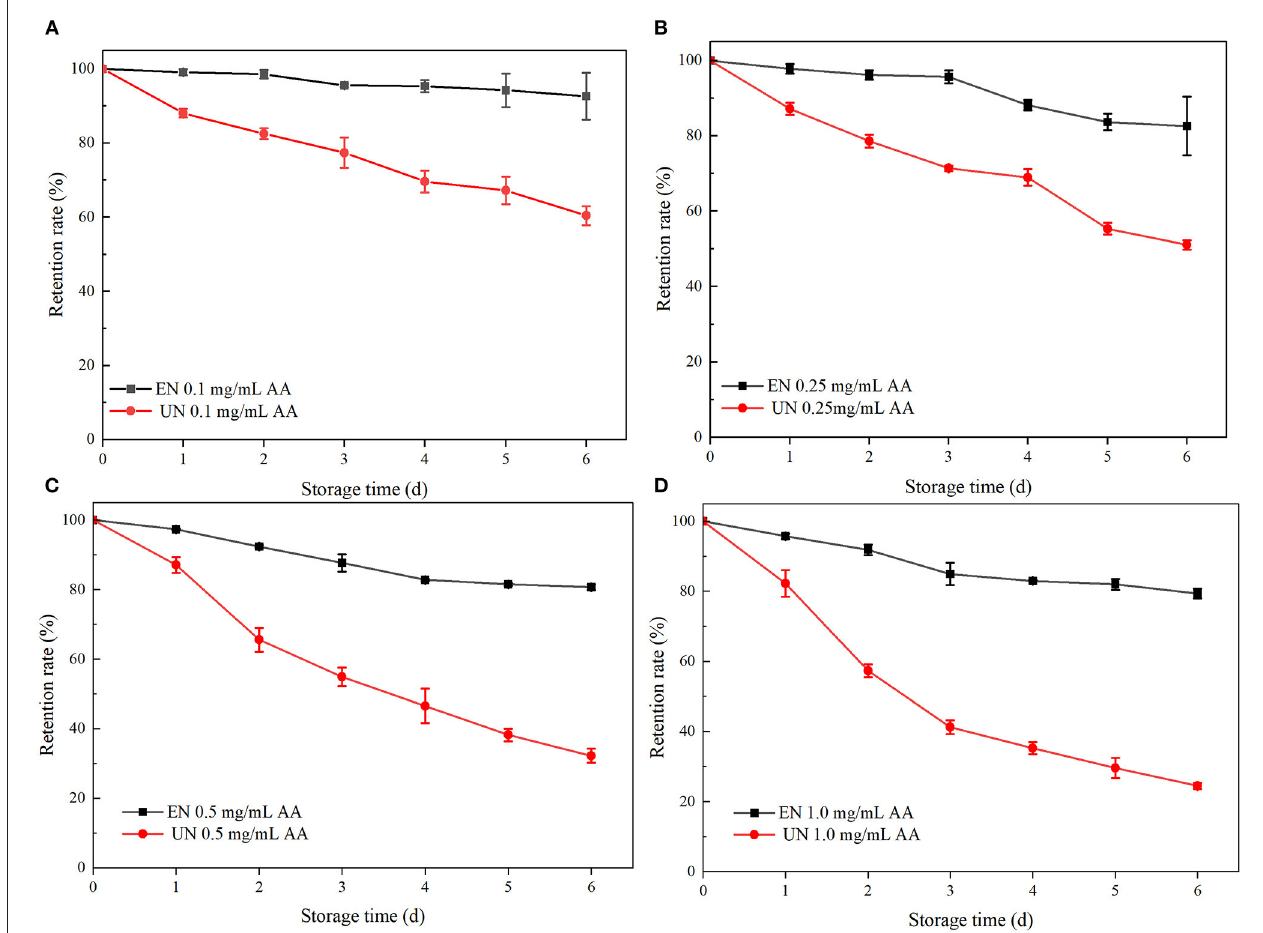
FIGURE 4 | The stability of black rice ATC at different ascorbic acid (AA) concentrations [ (A) 0.1 mg/mL AA, (B) 0.25 mg/mL AA, (C) 0.5 mg/mL AA, and (D) 1.0 mg/mL AA]. EN and UN represent HAA nanocomposite particles (embedded form) and black rice ATC (unembedded form),